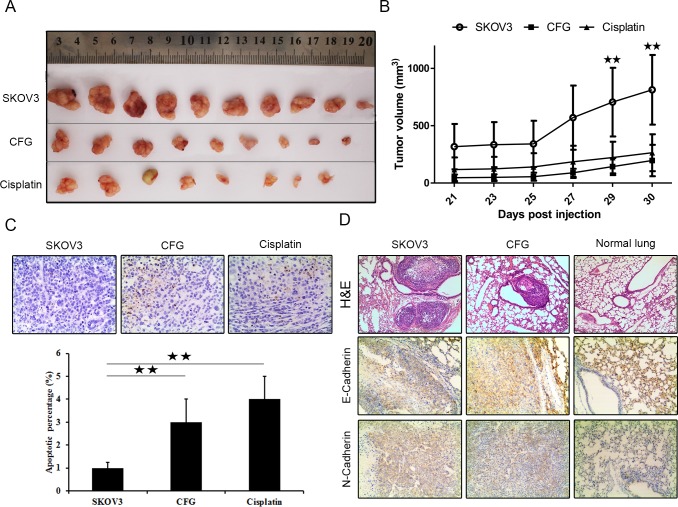
CFG treatment reduced tumor growth and metastasis in vivo xenograft mouse.(A) The photos of the tumor tissues dissected from the mice on day 44 after injection and with aforementioned treatment. (B) The tumor dynamic growth curves of different groups. (C) Tunel assay to show the apoptotic cells in the tumor tissues with indicated treatment at 200× magnification. Lower layer shows the percentage of apoptotic cells in each group. For A, B, and C, SKOV3: SKOV3 control group of subcutaneous injection; CFG: CFG group of subcutaneous injection; Cisplatin: Cisplatin group of subcutaneous injection. (E) H&E staining showed the lung metastases and immunochemistry staining to show the expression of E-Cadherin and N-Cadherin in each group. SKOV3: SKOV3 control group of tail intravenous injection; CFG: CFG group of tail intravenous injection; Normal lung: Normal group for tail intravenous injection. *p < 0.05 and **p < 0.01